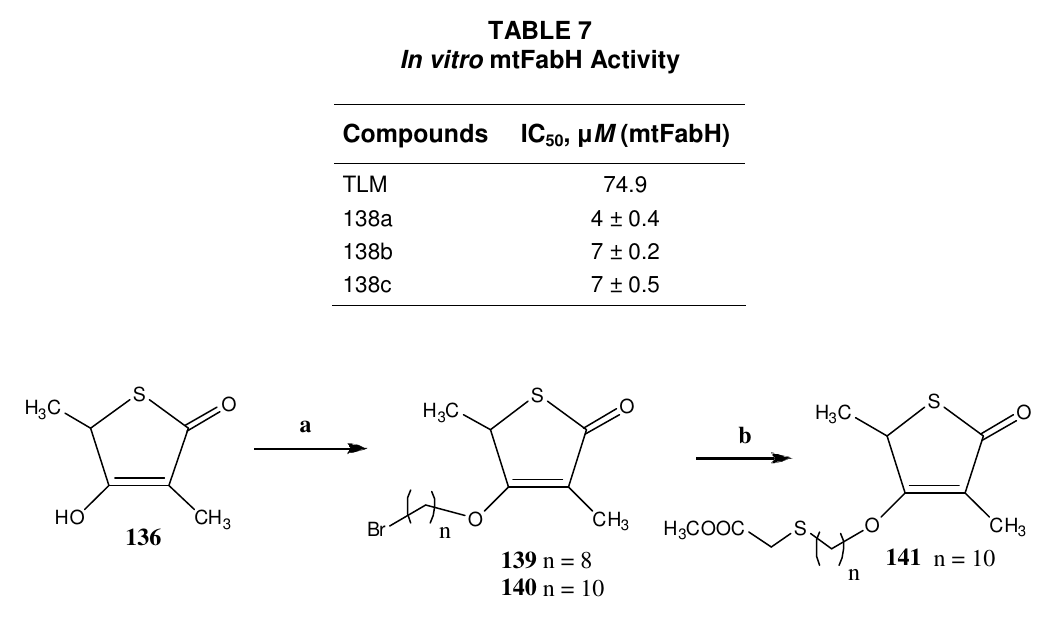
In vitro mtFabH Activity